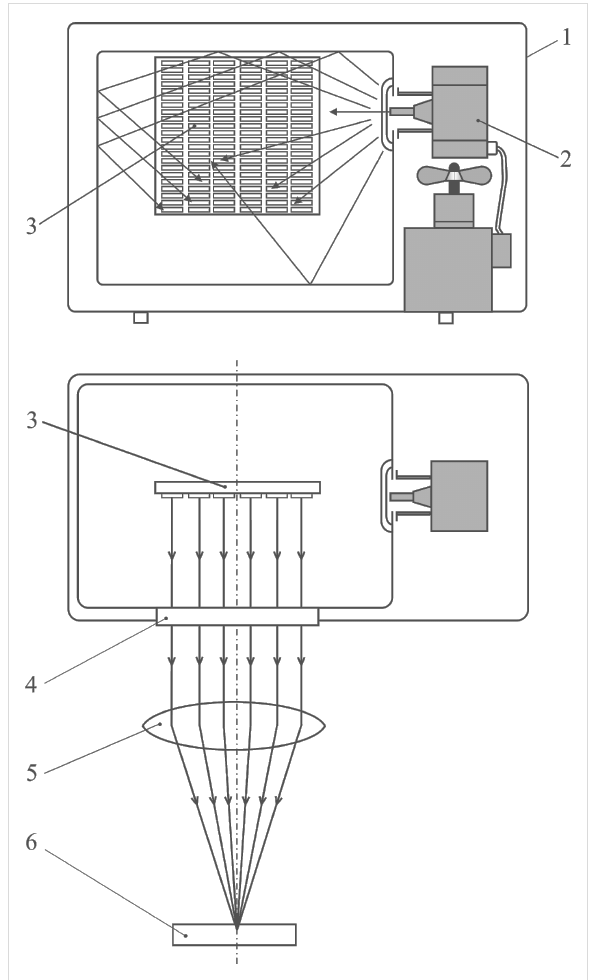
Figure 4: An outline of the THz radiation source based on a domestic microwave oven. 1: microwave oven, 2: magnetron ( ν = 2.45 GHz), 3: substrate with densely deposited GNBs or GNRs, 4: THz band reso- nance filter ( ν 0 = 4.2 THz), 5: lens, 6: object to be studied.